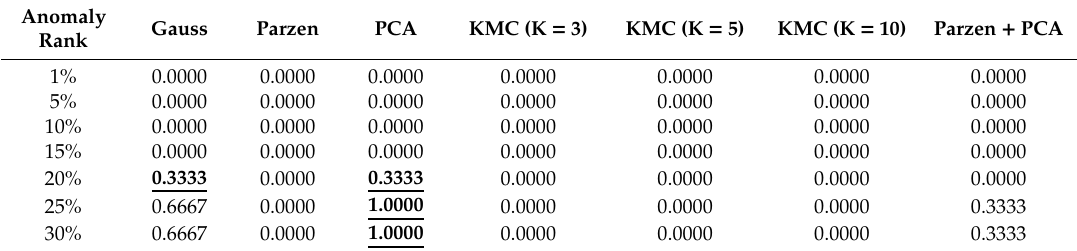
Table 17. True detection rate of each anomaly detection algorithm based on the e-mail communication network dataset (CMP2946). Best performance is shown in bold and underlined (number of normal behaviors in the test set: 474, number of malicious behaviors in the test set: 7).